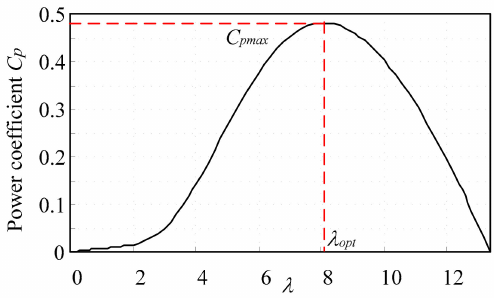
Figure 3. Curve of the tip speed ratio λ